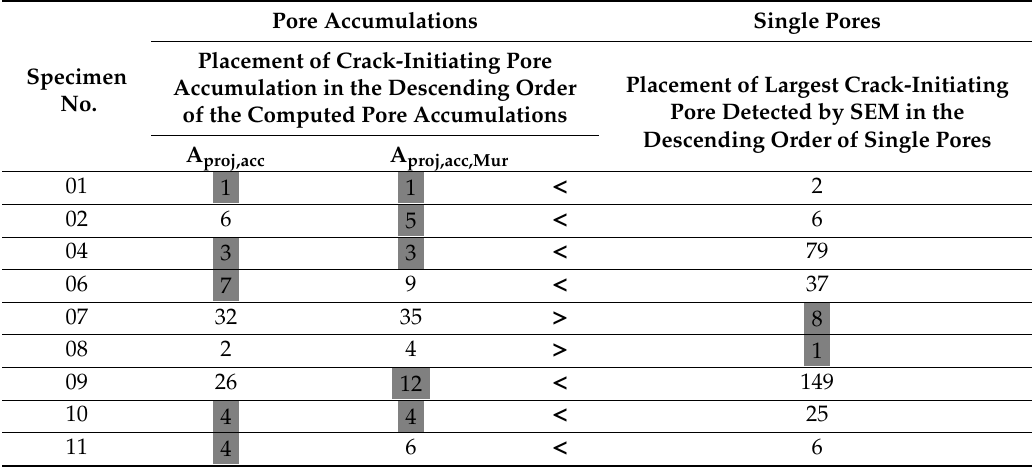
Table 1. Evaluation of the suitability of computing pore accumulations for crack origin assessment (a smaller number indicates a better placement and thus a better predictive accuracy of crack origins; number ‘1 (cid:48) means that the actual crack origin is exactly